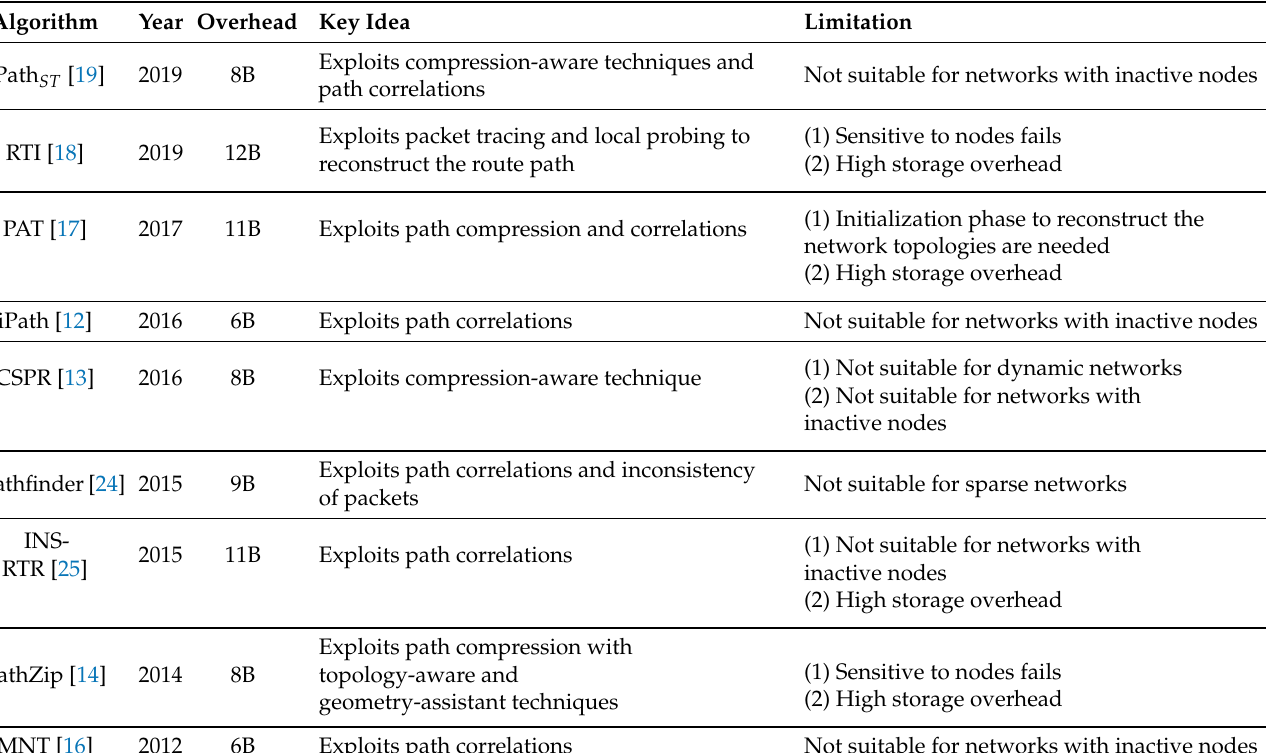
Table 1. Literature Review on Path Reconstruction